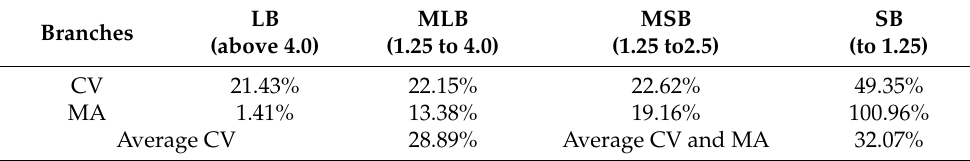
Table 6. Multi-criteria analysis of liquidation processes costs “costs